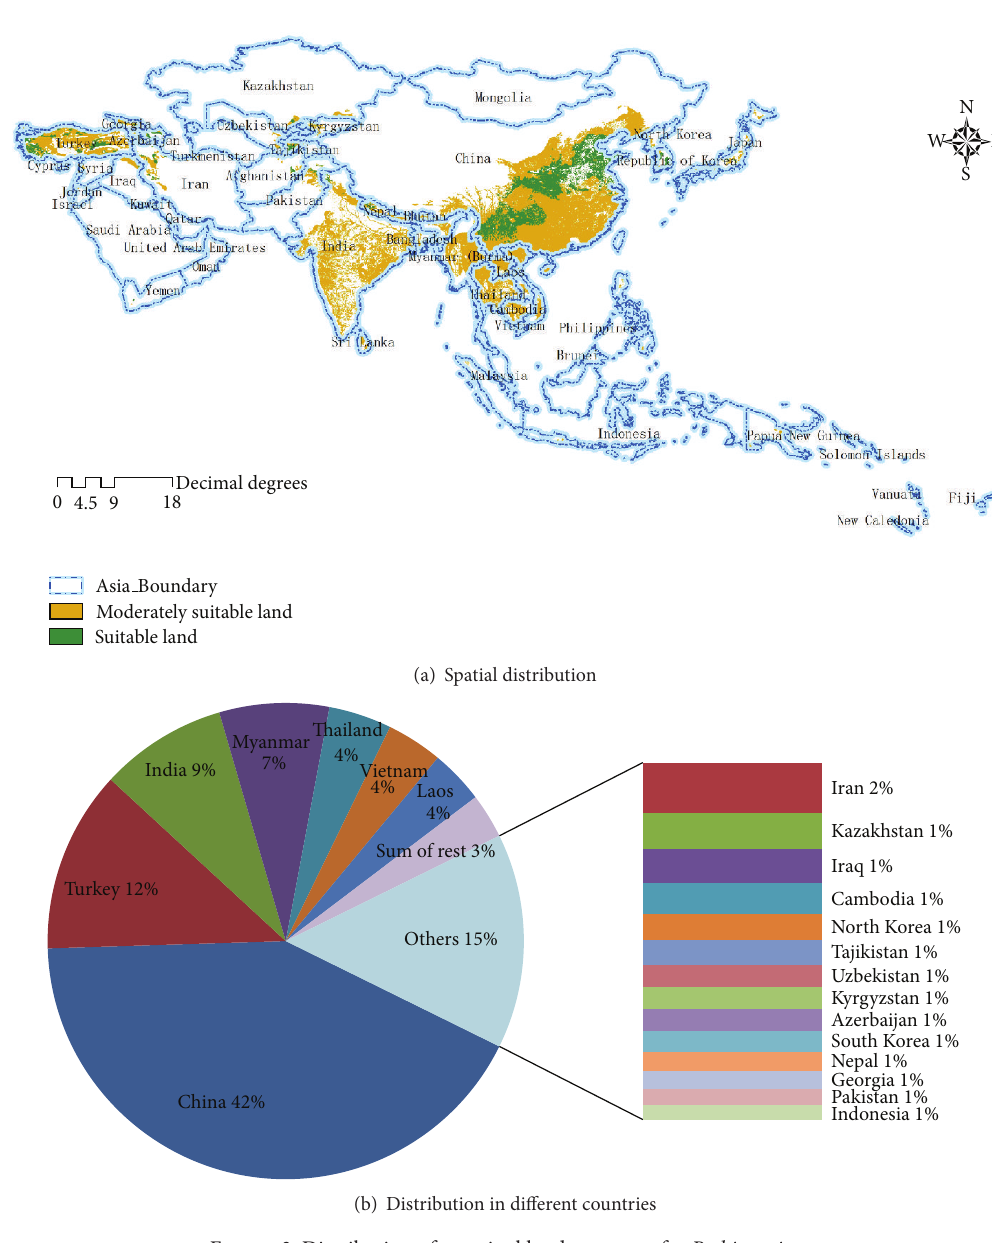
Figure 3: Distribution of marginal land resources for P. chinensis. Table3:Marginallandresourcessuitableandmoderatelysuitablefor Cassava,P. chinensis, and JCL plantingbasedonmultiplefactoranalysis in Asia (km 2